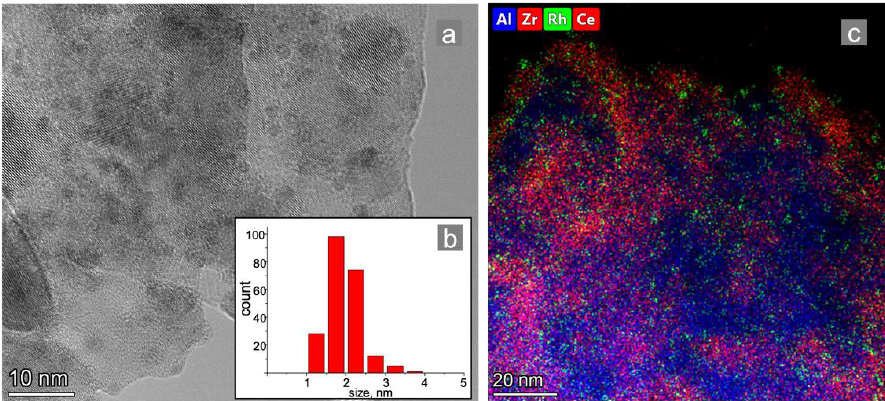
Figure 3. TEM images: ( a ) element distribution mapping of the ( c ) Rh/CZA/FeCrAl catalytic coating and ( b ) Rh particle size distribution.